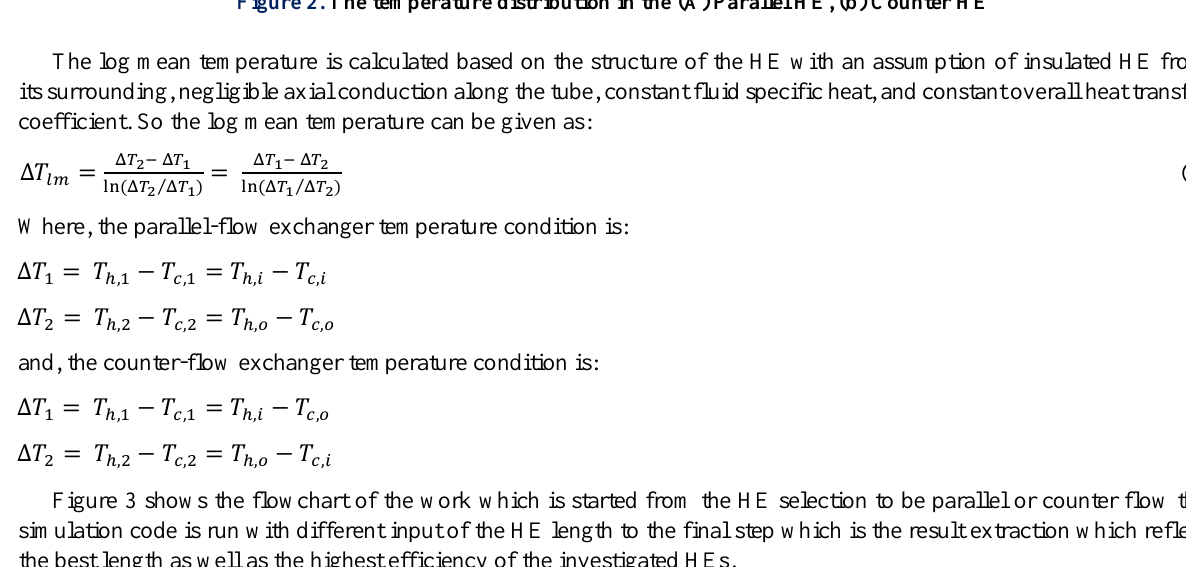
Figure 2. The temperature distribution in the (A) Parallel HE, (b) Counter HE